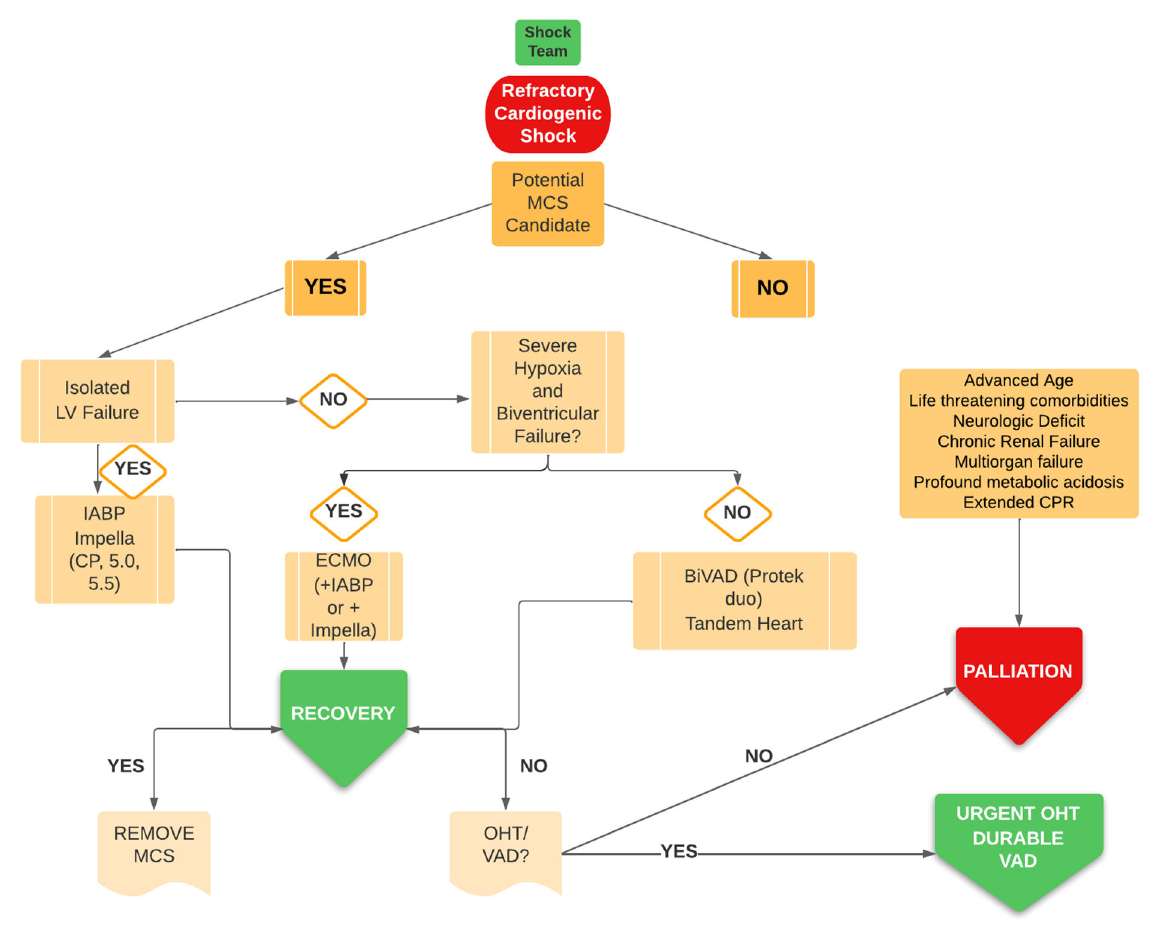
Figure 2. Decisional algoritm in CS. LV = left ventricle; ECMO = venoarterial extracorporeal membrane oxygenation; IABP = intraortic balloon counterpulsation.